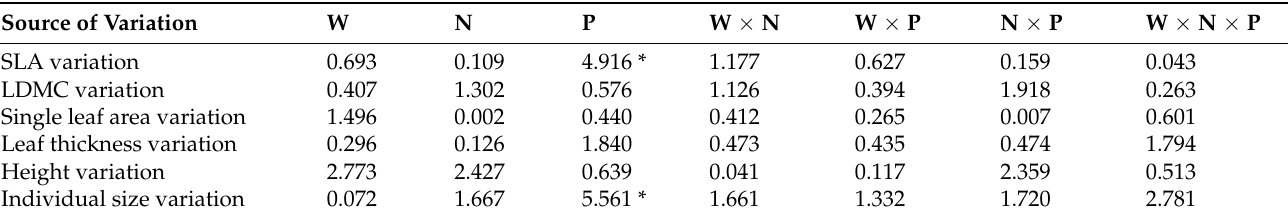
Table 3. Three-way ANOVAs of intraspecific trait variation in Potentilla anserina in response to three main factors and their interactions.